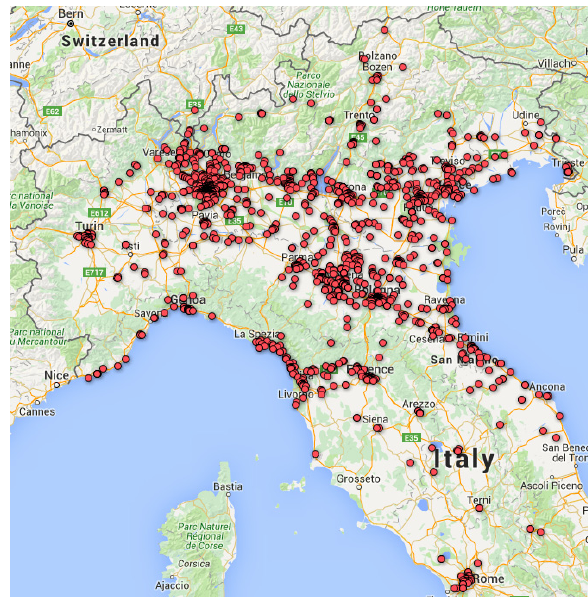
Figure 7. Tweets localization map: May 20, 2012, 2:00 a.m.-3:59 a.m UTC (Google Fusion Table).